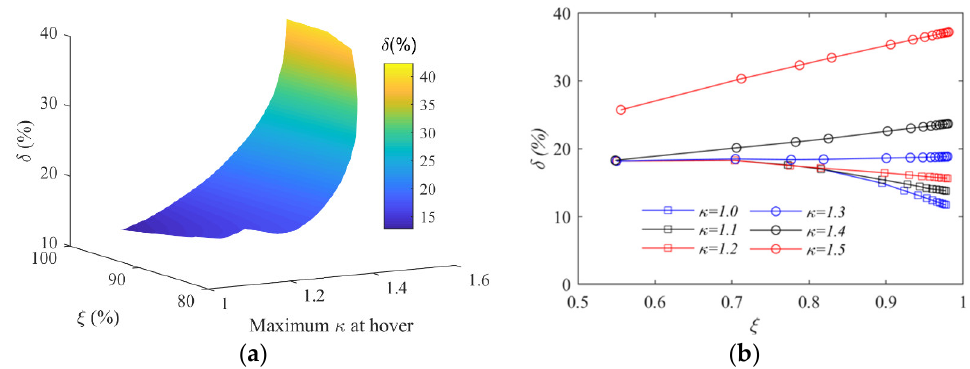
Figure 30. Energy-saving advantage of VPP over FPP with different ξ and κ . ( a ) 3D surface diagram of δ , ξ and κ ; ( b ) δ − ξ relation curves with different κ